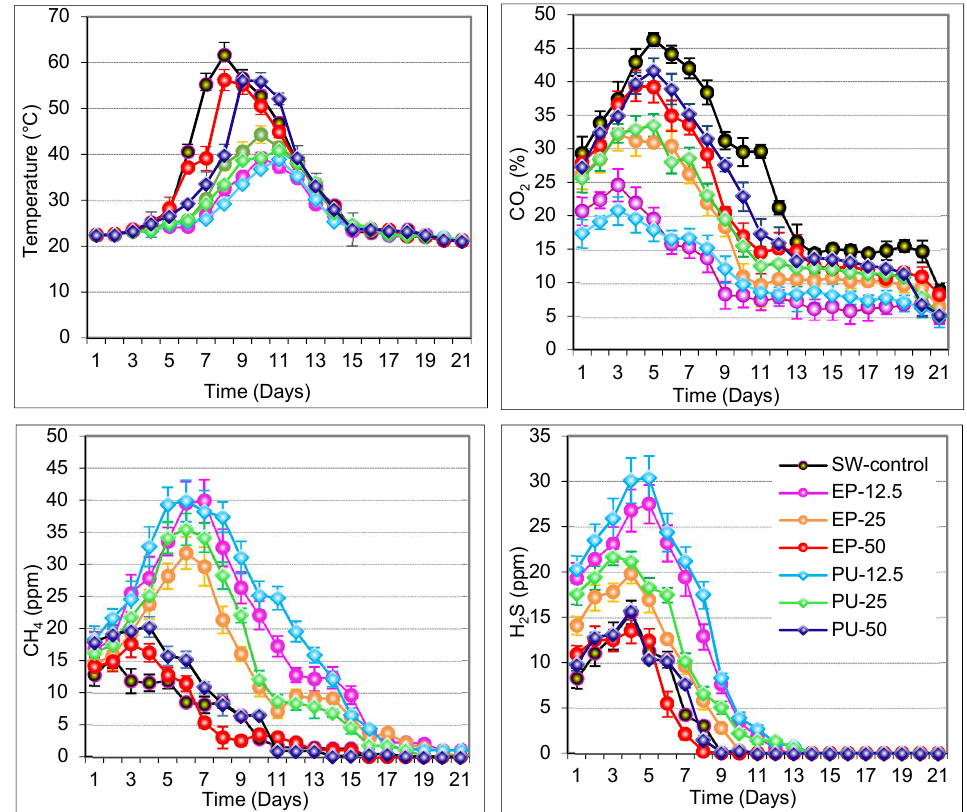
Figure 1. Temperature change, CO 2 evolution, CH 4 generation and H 2 S emission during composting. Error bars represent the standard deviation for mean values of three replicates. SW sawdust, EP expanded perlite, and PU pumice at 12.5, 25, and 50% incorporation rate into compost mixture.